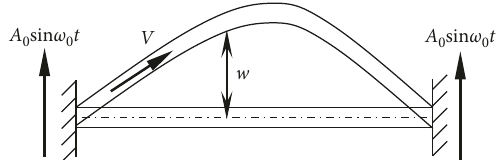
Figure 16: Schematic of a clamped-clamped PCF.